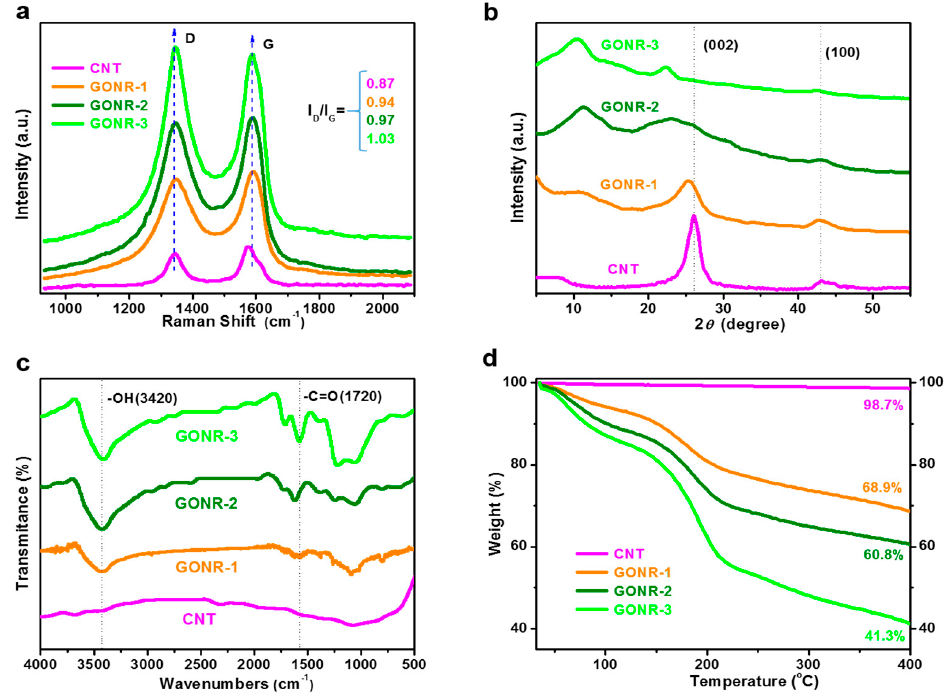
Figure 2. Structural characterization and analysis: ( a ) Raman spectra; ( b ) XRD curves; ( c ) FTIR spectra; ( d ) TGA curves of CNT and GONRs with different morphology and structure, indicating the different oxidation degree.